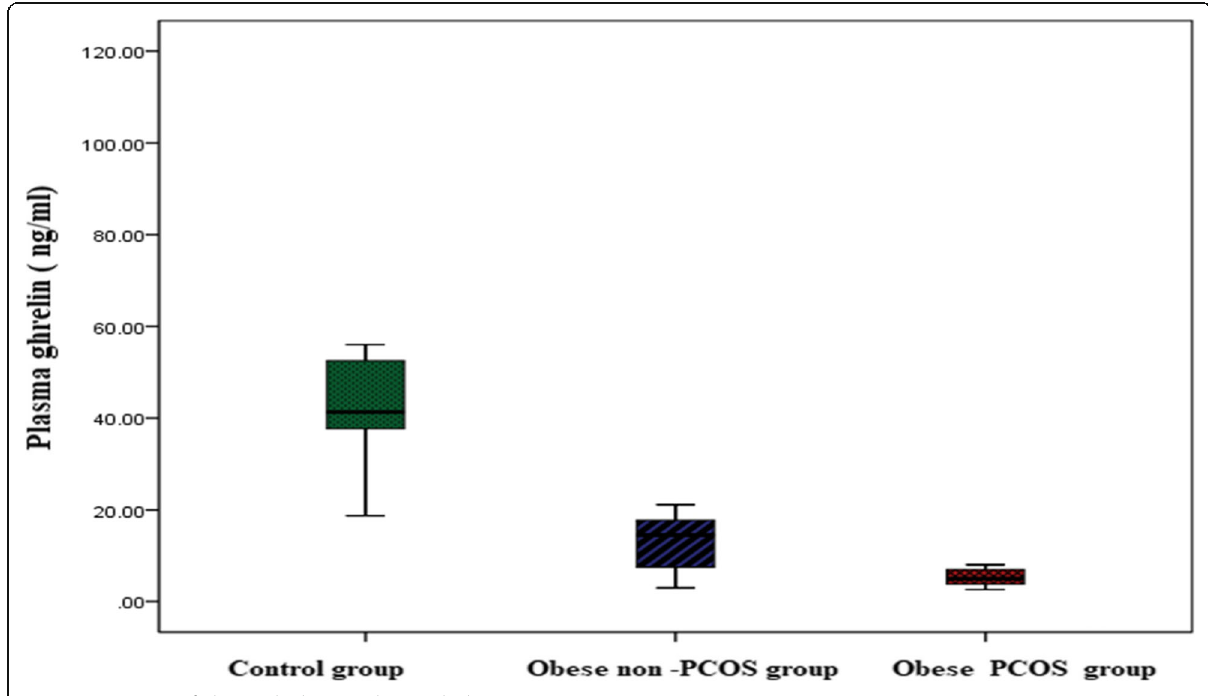
Fig. 1 Comparison of plasma ghrelin (ng/ml) in studied groups